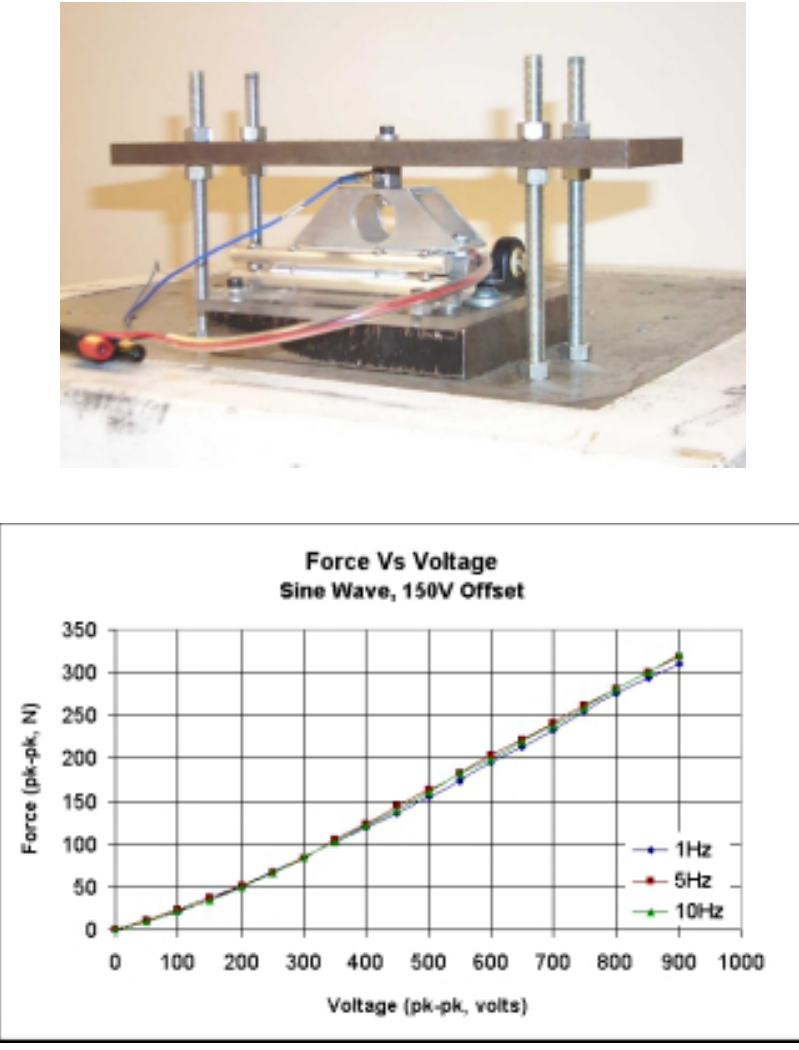
Fig. 10. Experimental setup for blocked force measurement (top) and measured blocked force versus